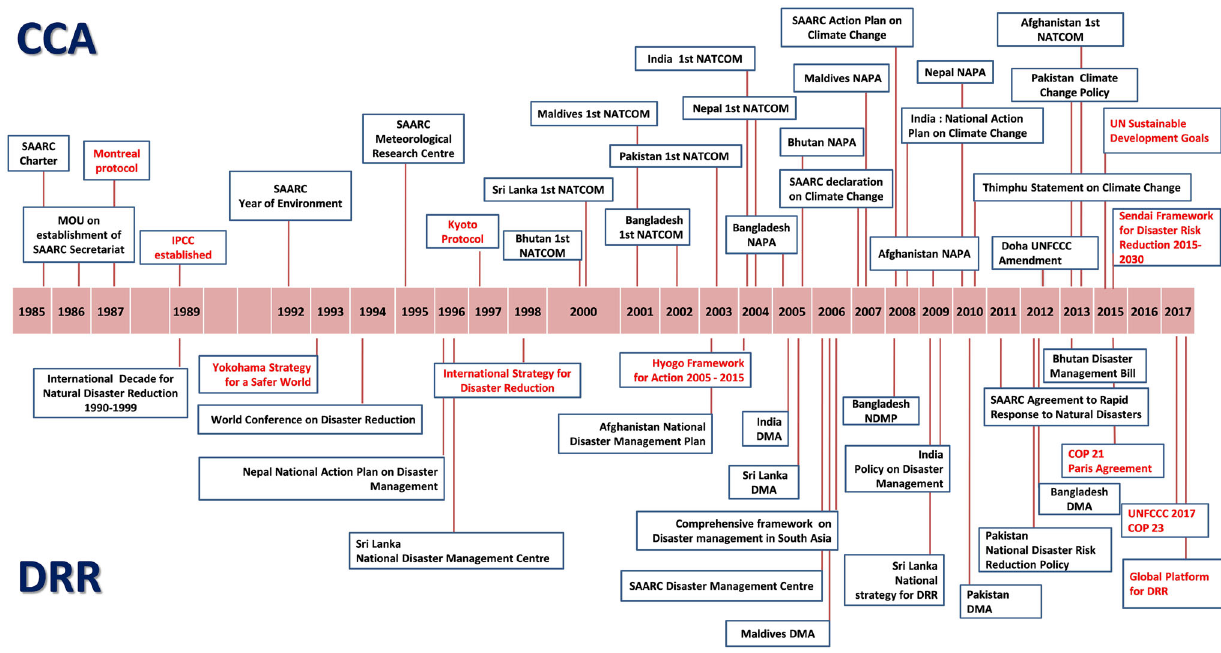
Fig. 1 Time series for development of major approaches, legislations, and institutions for climate change adaptation (CCA) and disaster risk reduction (DRR) in South Asia. Note : Boxes with red font colour indicate conventions/treaties with international